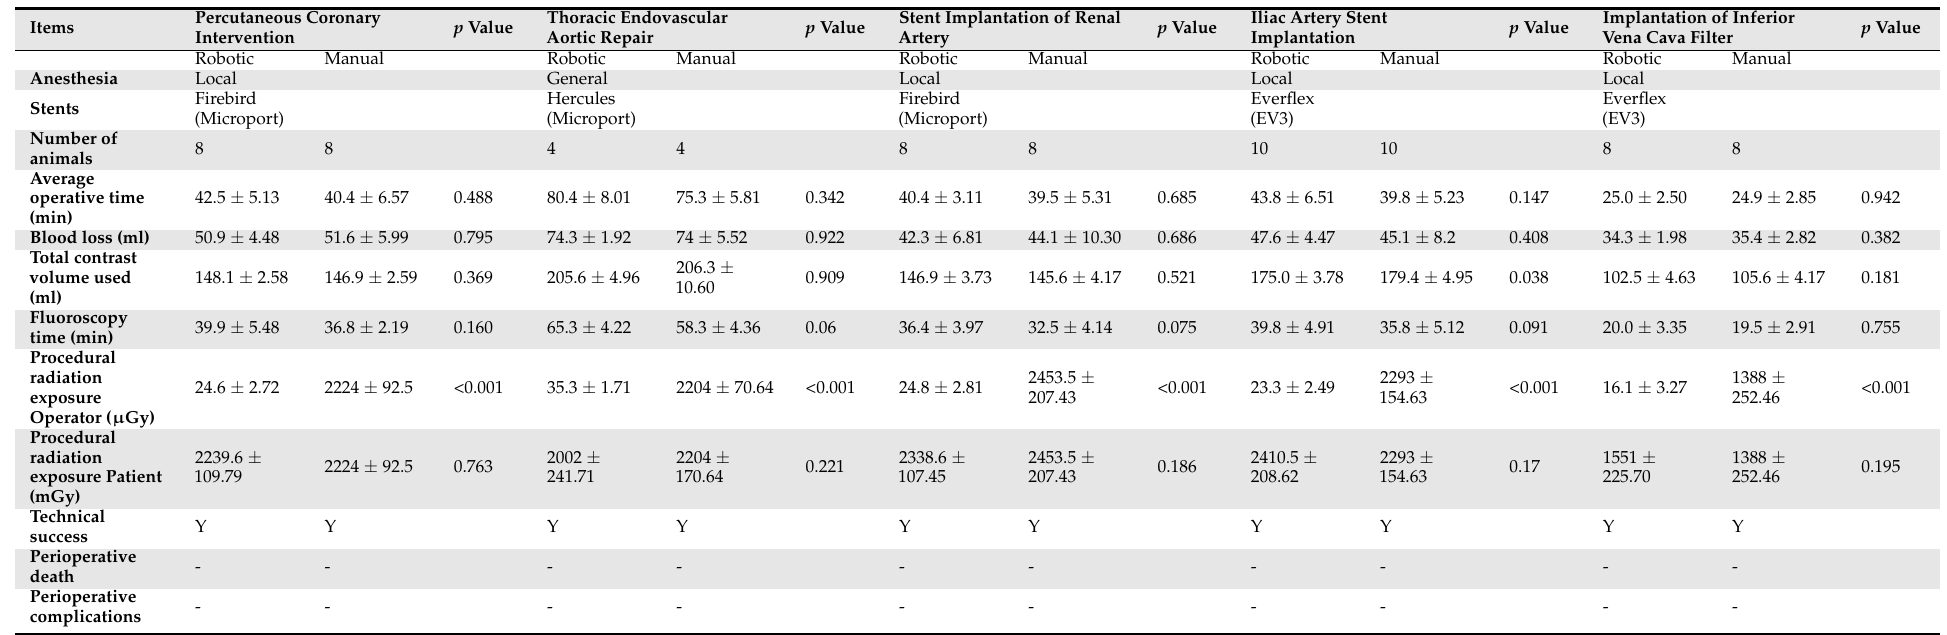
Table 2. Detailed information regarding the procedure